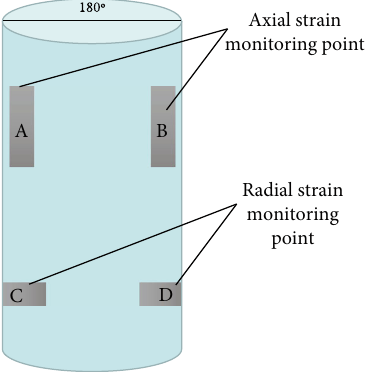
Figure 2: Schematic diagram of the strain